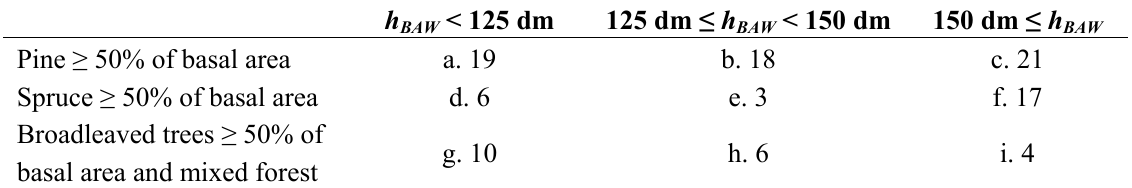
Table 1. Number of field plots in strata based on species composition and basal area-weighted mean height ( h ). BAW